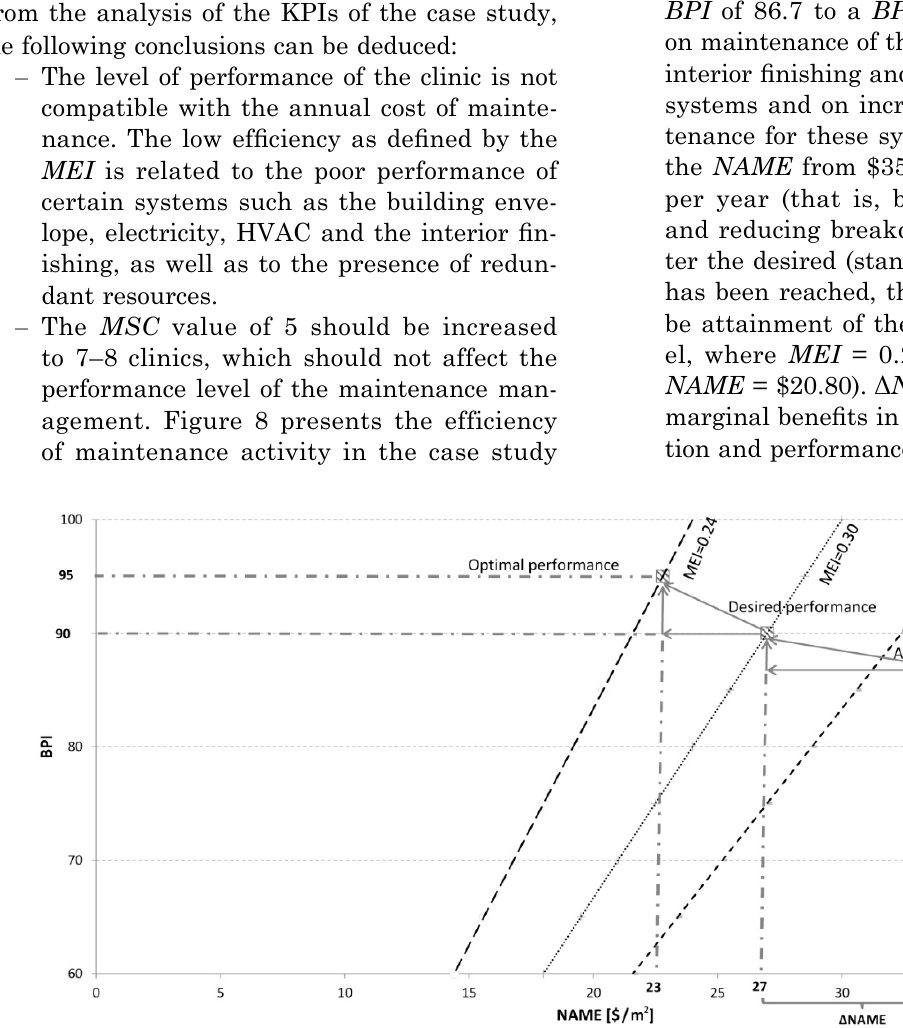
Fig. 8. Actual and desired performance of the clinic and corrective